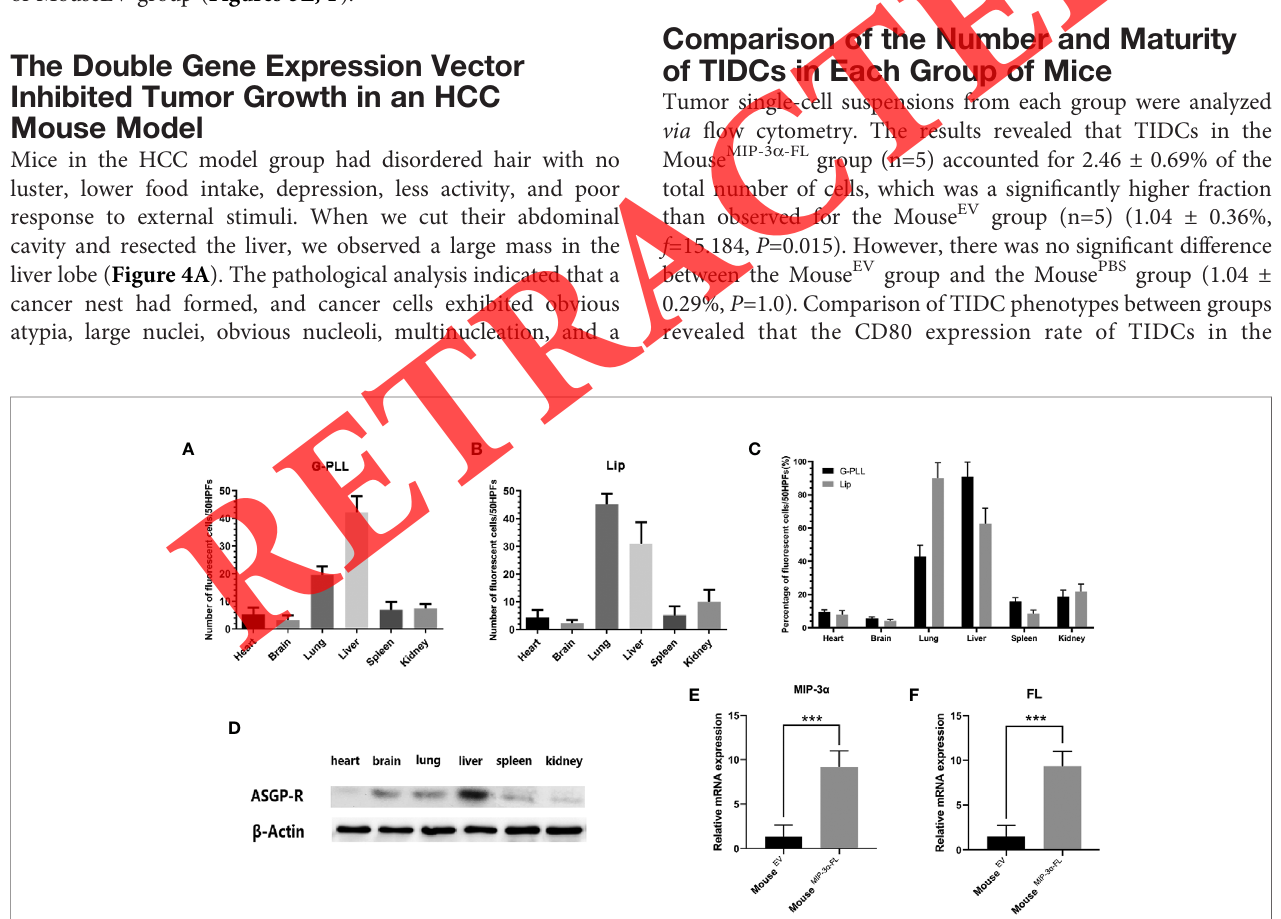
FIGURE 3 | Comparison of transfection ef fi ciency of different tissues. (A) The transfection ef fi ciency mediated by G-PLL. (B) The transfection ef fi ciency mediated by Lip. (C) Percentage of fl uorescent cells in different organs mediated by G-PLL and Lip. (D) The expression of ASGP-R in different mouse tissues. (E) Relative expression of MIP-3 a mRNA in the two groups of samples. (F) Relative expression of MIP-3 a mRNA in the two groups of samples. *** P